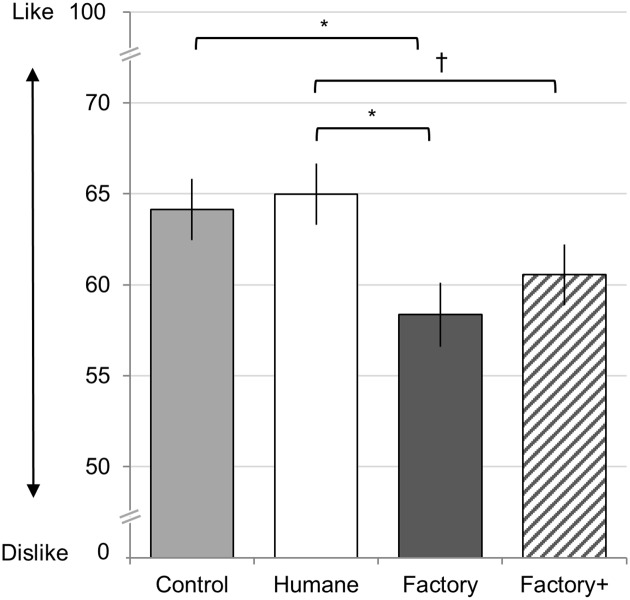
Study 2: Ratings of Roast Beef Sample.Error bars represent standard errors. Asterisks represent significance (* p < 0.05), and dagger represents trend († p < 0.07). All ratings made on 100 millimeter general Labeled Magnitude Scale.